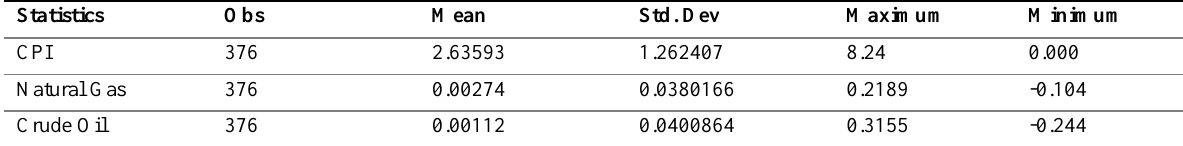
Table 1: Summary statistics for the